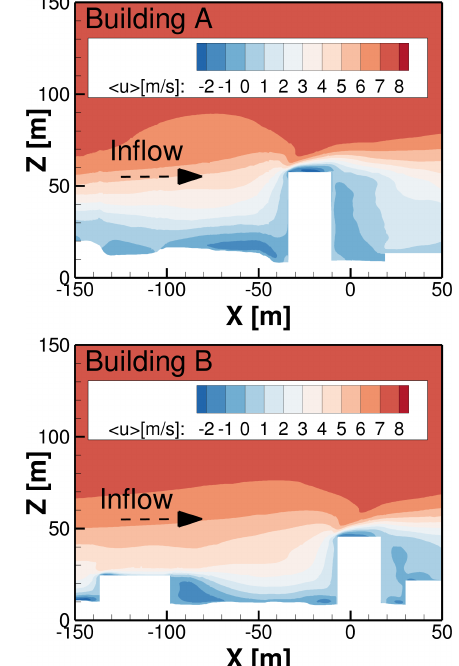
Figure 10. Distribution of averaged u component of velocity in the plane Y = 0m and Y = 110m passing through building A and B.